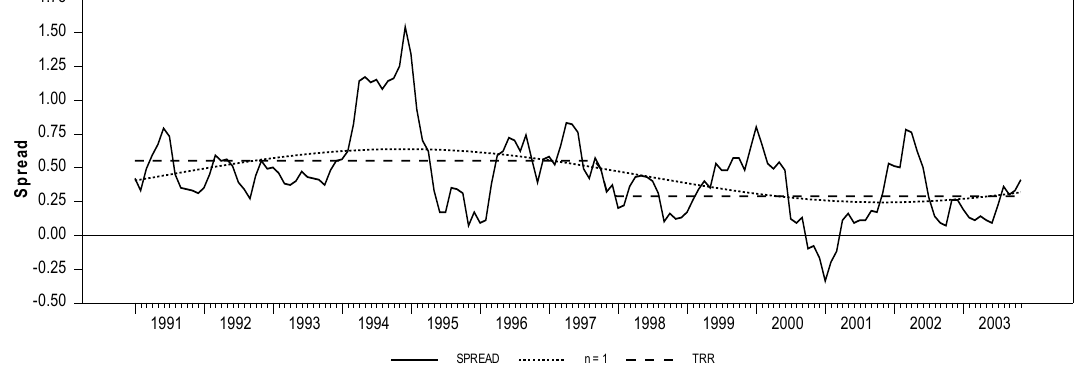
Figure 2. The R1–T–bill spread, the Fourier intercept and the smooth transition (ST) trend.